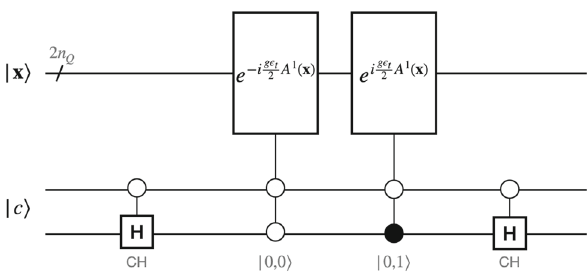
Fig. 4 Implementation of the (infinitesimal) time evolution operator generated by H A 1